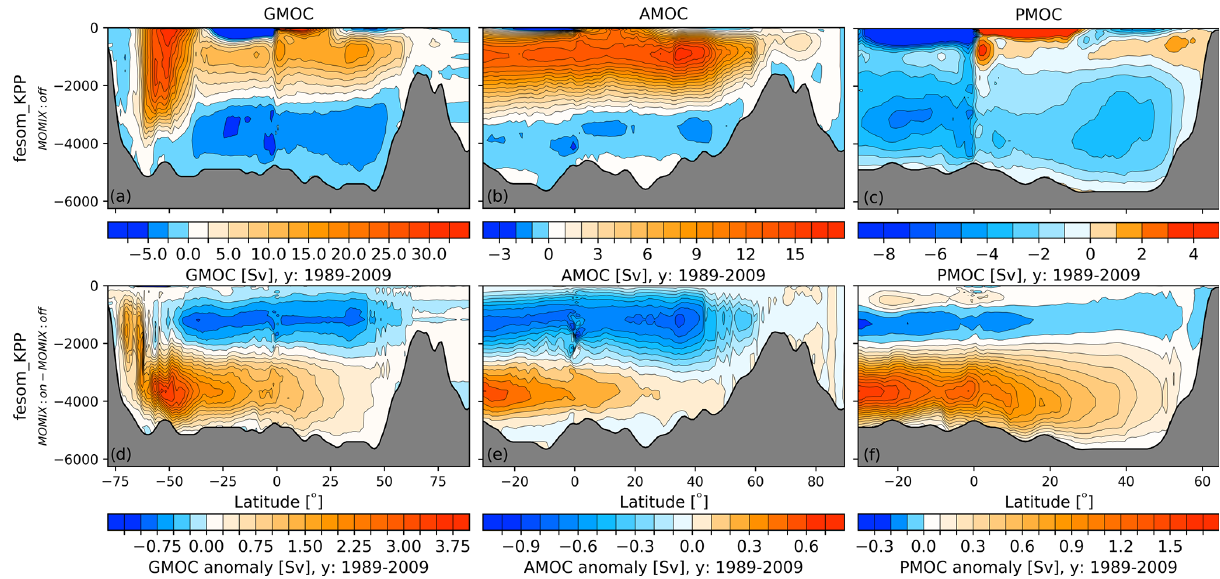
Figure 22. Absolute (a–c) and anomalous (d–f) global (GMOC, a, d ), Atlantic (AMOC, b, e ) and Indo-Pacific (PMOC, c, f ) meridional overturning circulations averaged for the time period 1989–2009. Absolute values are shown for fesom_KPP with switched-off Monin– Obukhov vertical mixing (MOMIX) parameterisation, anomalous values show the difference between fesom_KPP with switched-on and switched-off MOMIX